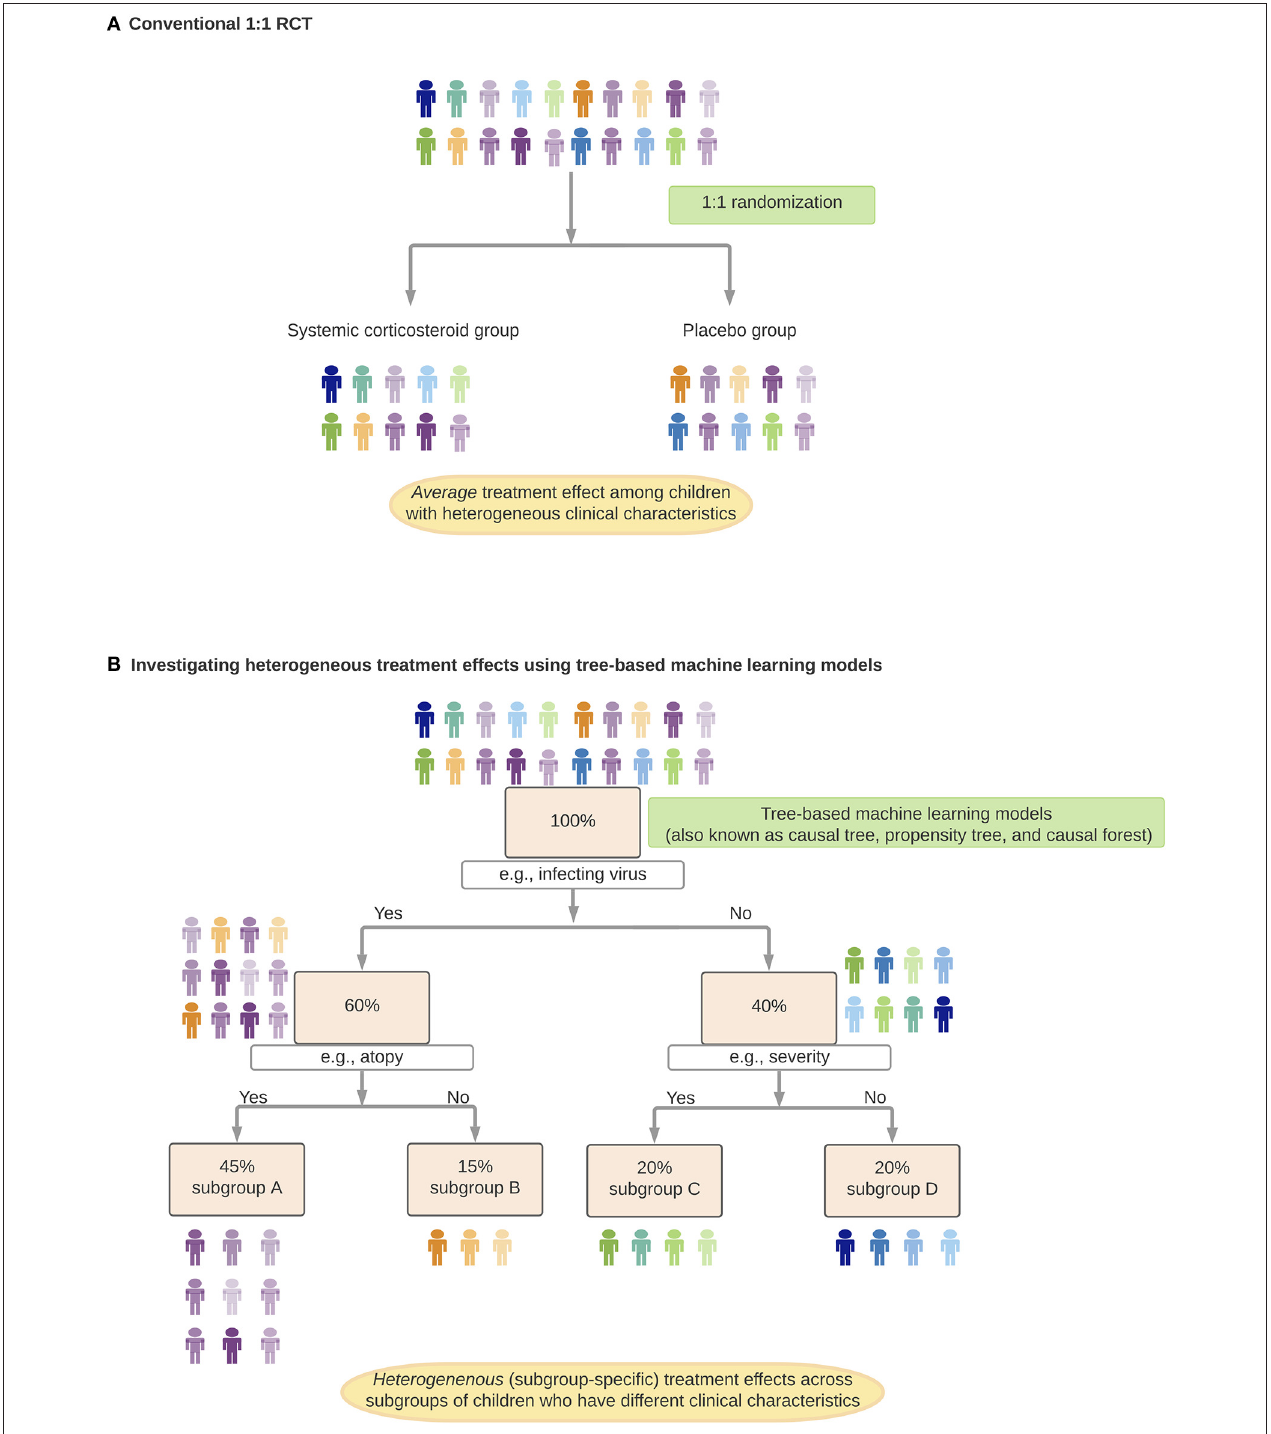
FIGURE 2 | Identification and estimation of heterogenous treatment effects. In this hypothetical example, suppose, we investigate treatment effects of systemic corticosteroids on hospitalization rates among preschool children with virus-induced wheezing. (A) Randomized control trial (RCT) to investigate the average treatment effect of systemic corticosteroids (conventional 1:1 RCT). (B) Investigating heterogeneous treatment effects using tree-based machine learning models. In each of the branches (e.g., subgroup A children have specific virus infection and a history of atopy), children have a comparable predicted probability of receiving systemic corticosteroids. Children within each subgroup function as if they came from an RCT with eligibility criteria stratified by clinical characteristics.